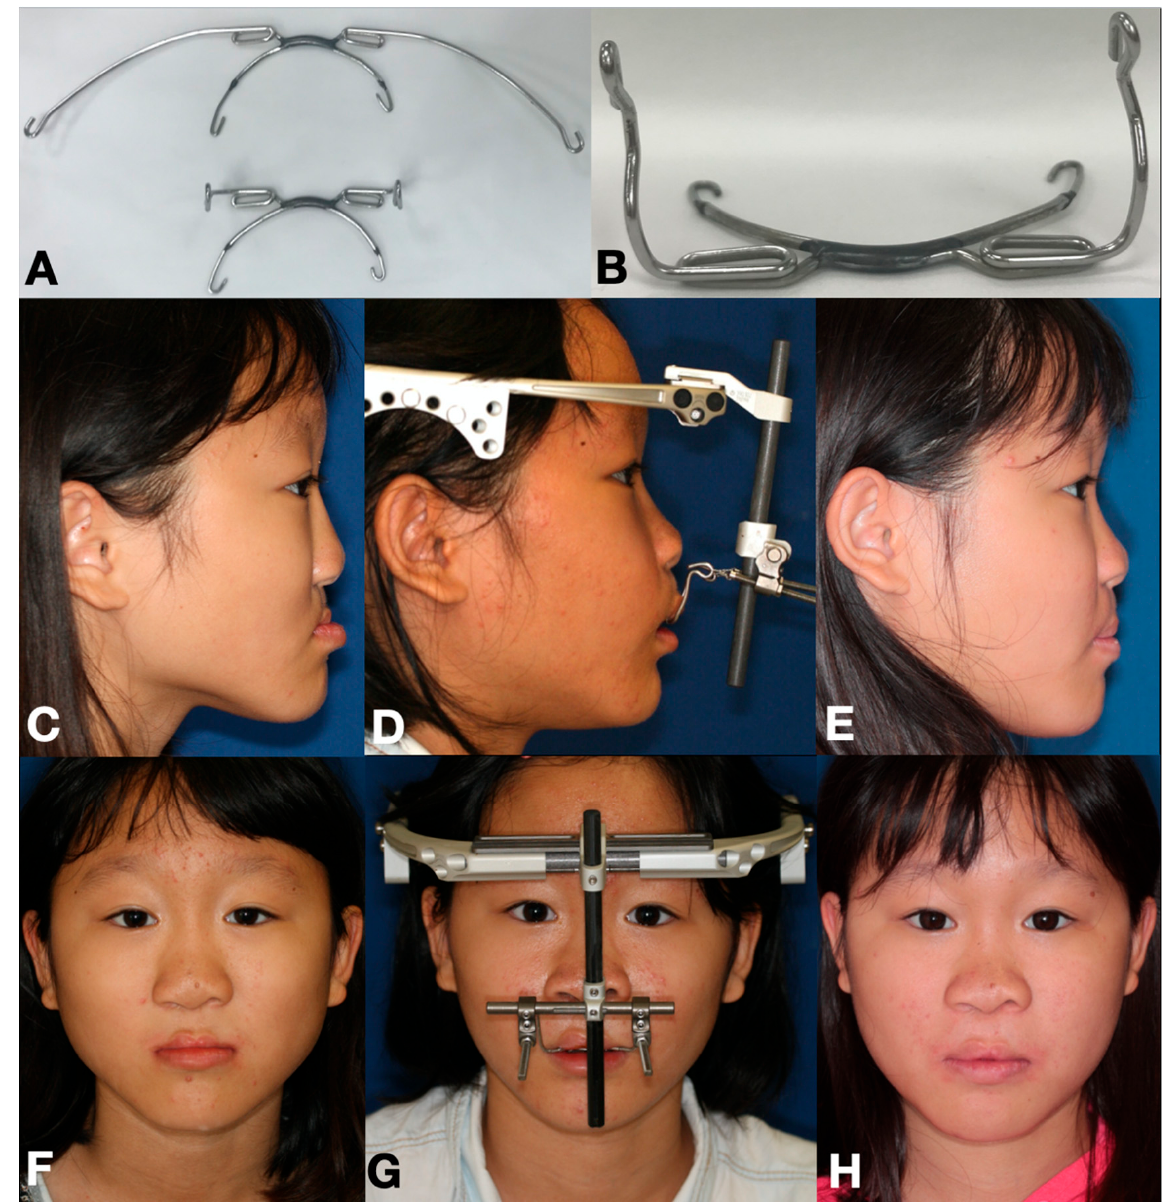
Figure 1. An eleven-year-old girl with cleft-related maxillary hypoplasia was treated with the tradi- tional tooth-borne RED system for distraction osteogenesis. ( A , B ) Intra-oral splint was modified from orthodontic headgear appliance. ( C – E ) Lateral profile changes before surgery, immediate after distraction, and after 1.5-year review. ( F – H ) Frontal appearance changes during the three stages mentioned